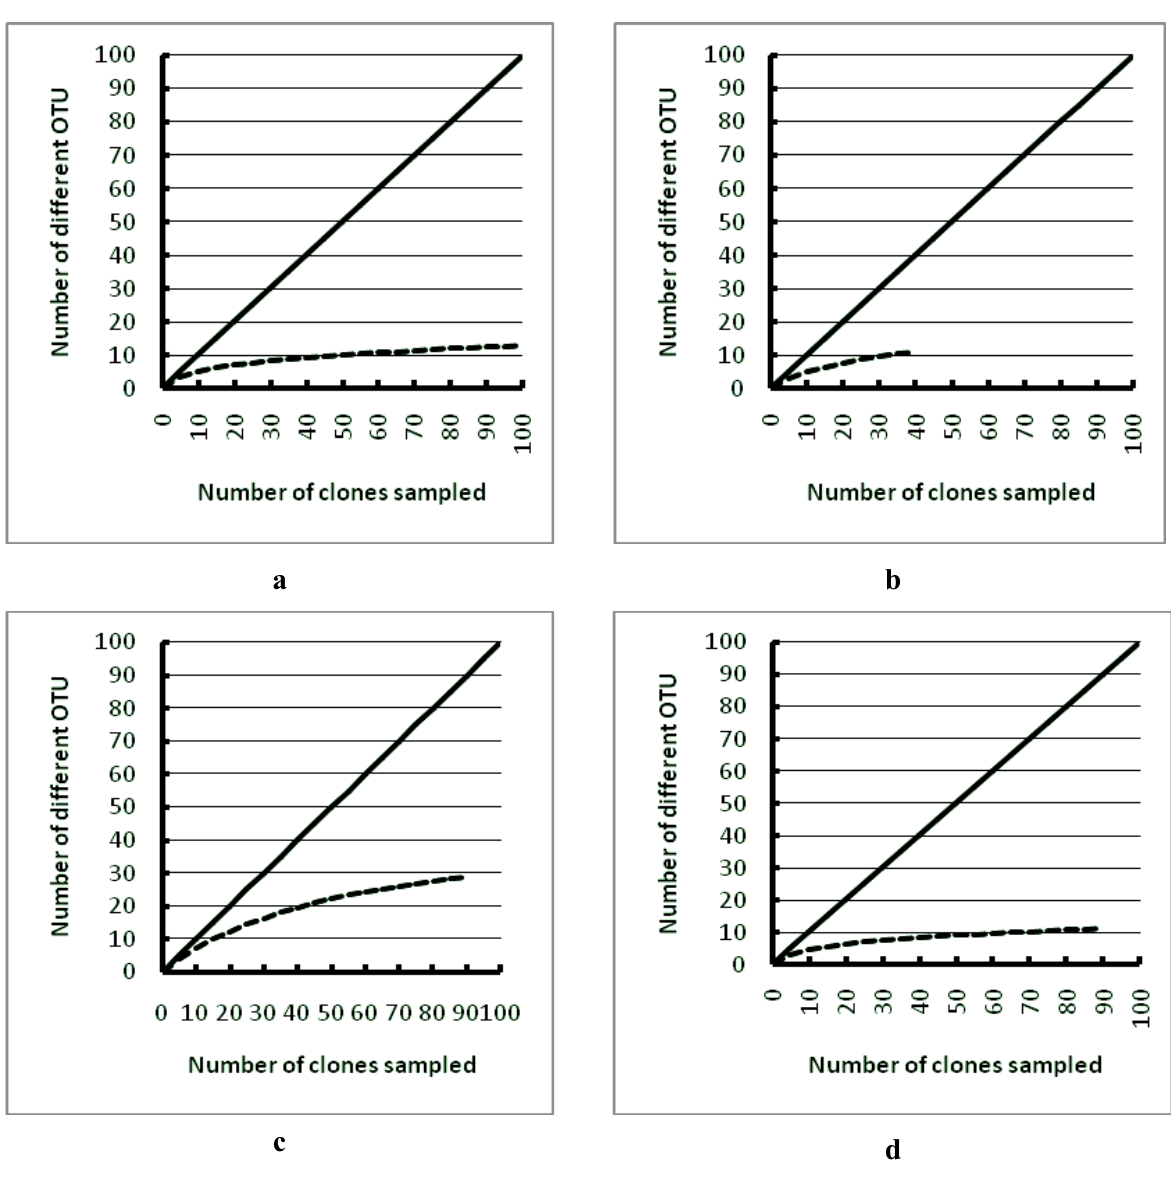
Figure 6. (cid:38)(cid:82)(cid:79)(cid:79)(cid:72)(cid:70)(cid:87)(cid:82)(cid:85)(cid:182)(cid:86)(cid:3)(cid:70)(cid:88)(cid:85)(cid:89)(cid:72)(cid:86)(cid:3)(cid:73)(cid:82)(cid:85) : ( a ) Eukarya ice; ( b ) Eukarya water; ( c ) bacteria ice; and ( d ) bacteria water clone libraries. The top line in each graph shows the hypothetical line if each clone belonged to a novel